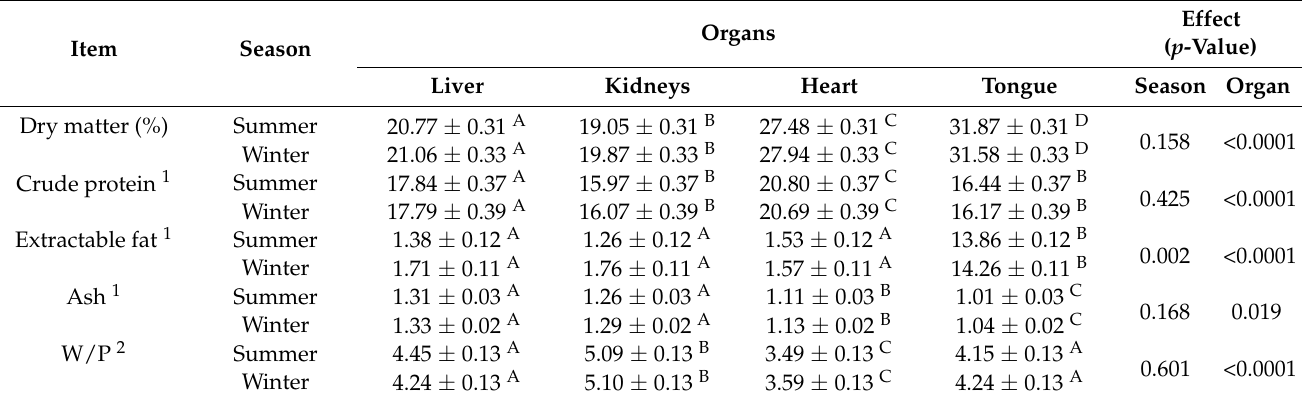
Table 6. Seasonal variation in the chemical composition of edible internal organs from the wild fallow deer (LSM ±